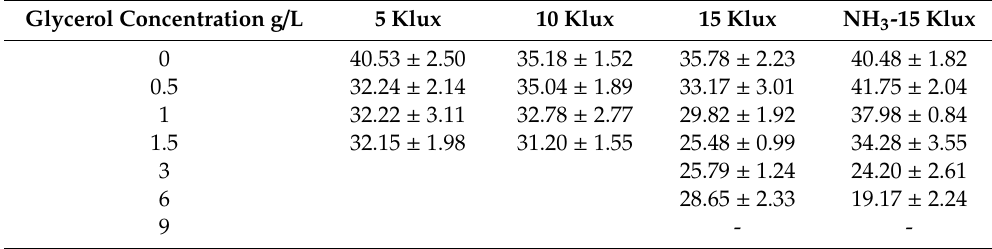
Table 3. Carbohydrate content of A. platensis cultivated under di ff erent glycerol concentrations and light